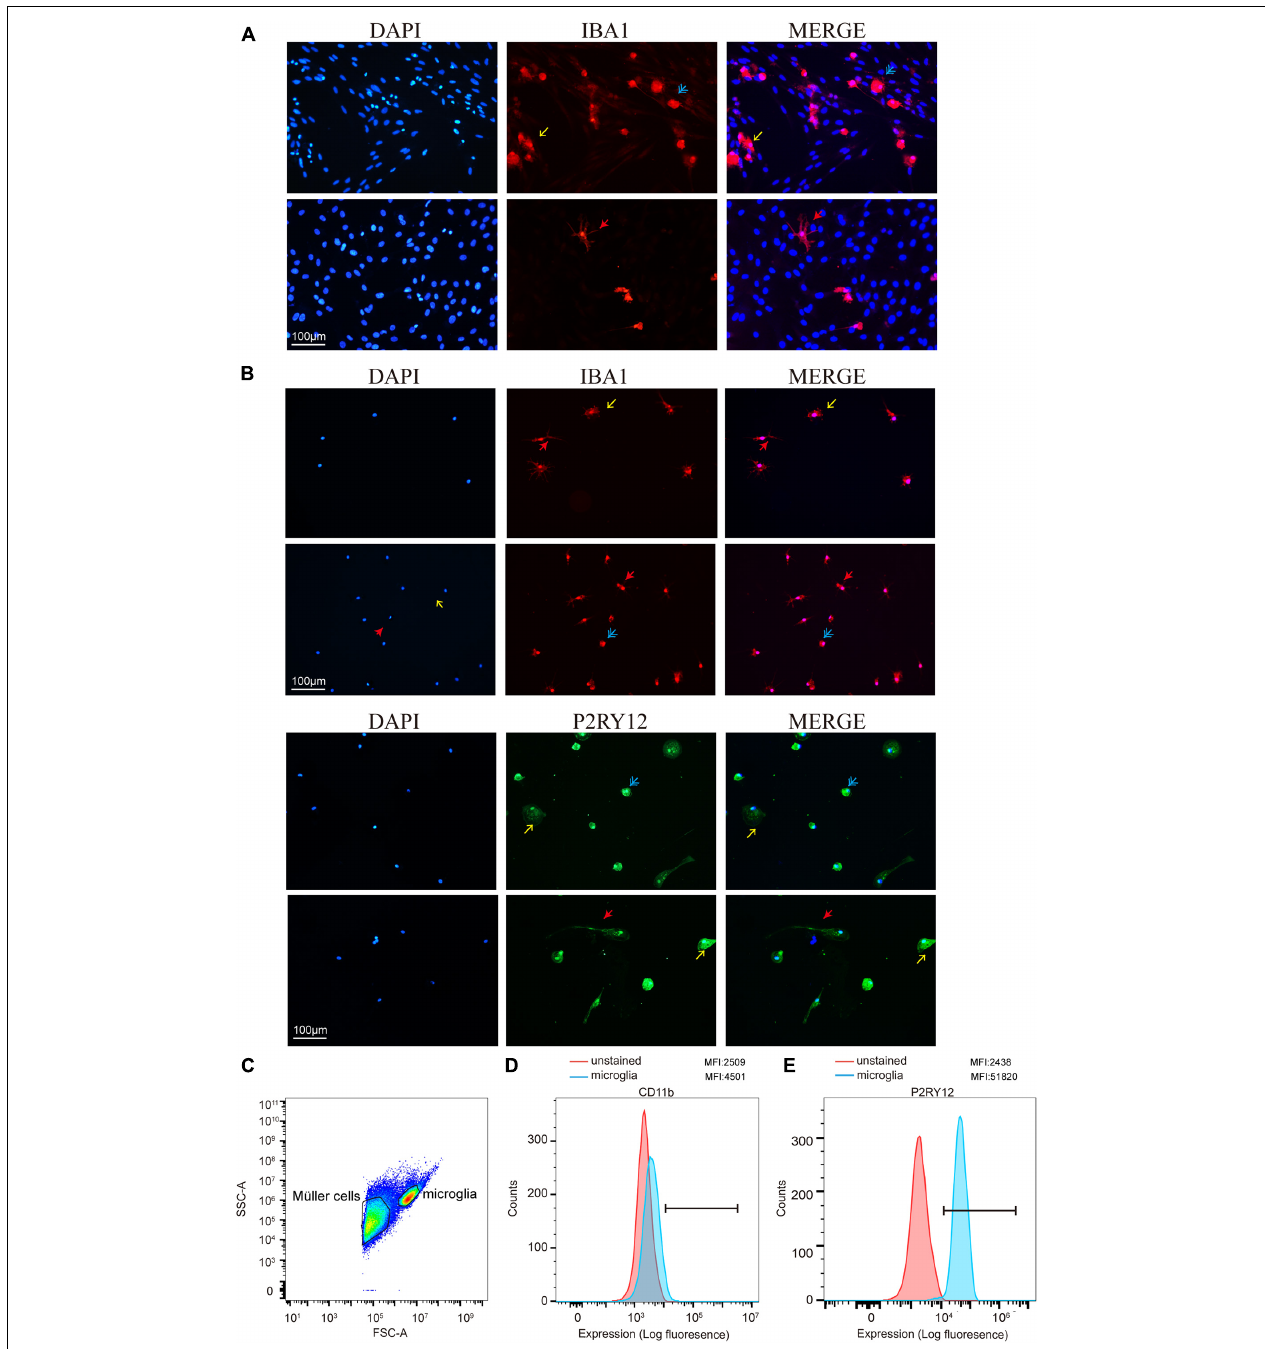
FIGURE 3 | Retinal microglia expressed characteristic cell markers. (A) Iba1 was used to specify cultured retinal microglia before being shaken (red). (B) Immunofluorescence staining of cells was shown positive for microglia markers Iba1 and P2RY12 after shaking from Müller cells and plating on a 24-well plate. (C) FACS plot displaying the gates for both Müller cells and microglia cells. (D,E) Data presented show mean fluorescence intensity (MFI) of CD11b and P2RY12 expression on microglia. CD11b and P2RY12 positive cells were shown as blue populations and non-labeled as red (Blue: rounded; yellow: ameboid; red: ramified; and scale bar: 100 µ